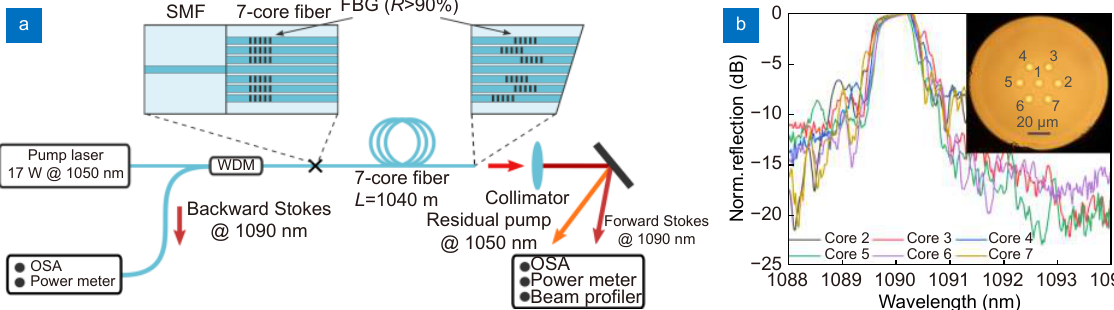
Fig. 12 | ( a ) 7-core fiber Raman laser scheme. ( b ) Reflection spectra measured for FBGs written in the side cores of the MCF. The inset shows the cleaved end of the MCF fiber used in the